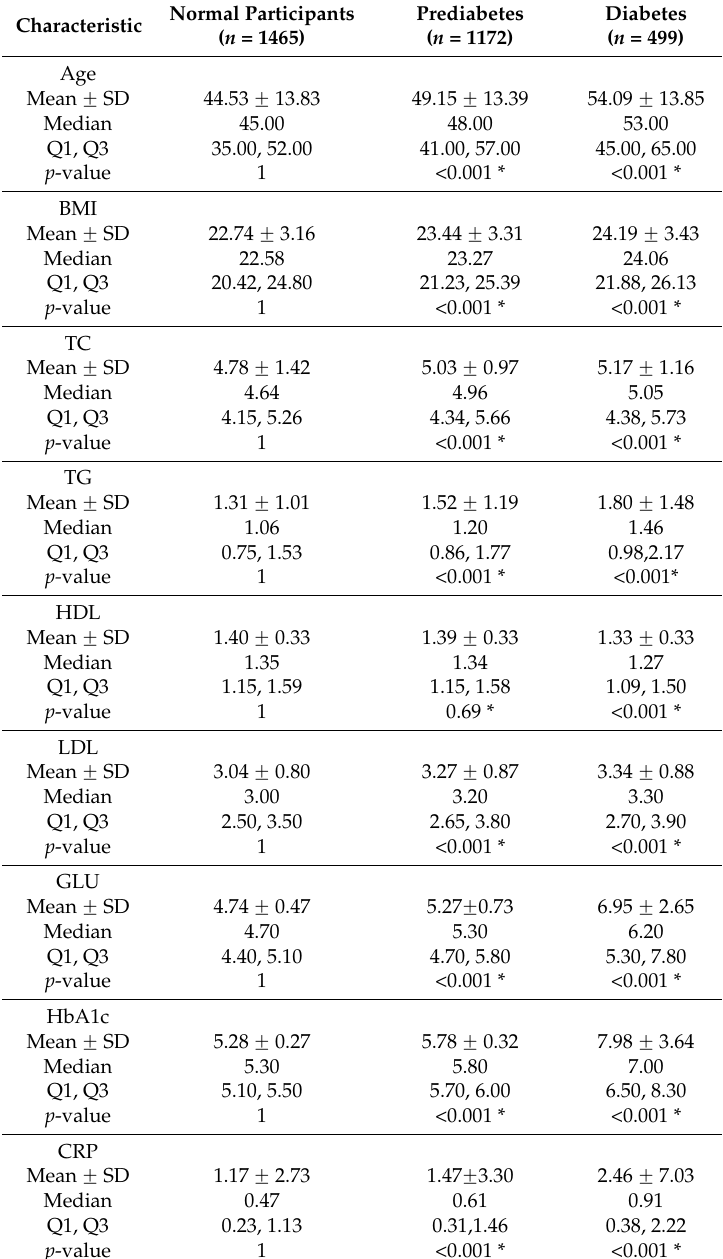
Table 3. Characteristics of participants with prediabetes, diabetes, and normal